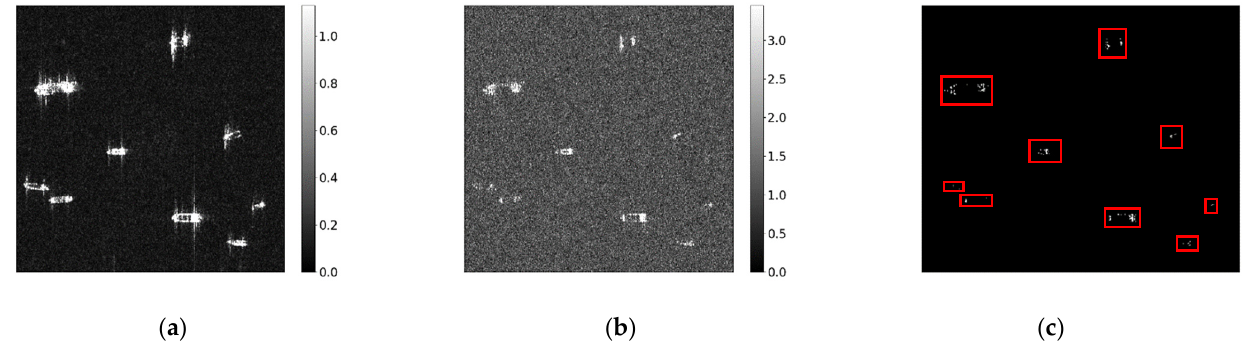
Figure 6. ( a ) Reference TerraSAR-X image in spotlight mode, ( b ) simulated image as if acquired with one of the two ambiguous modes that considers the worse NESZ and the increased sea clutter level due to the higher ambiguity level, and ( c ) the detection map with the regions of interest indi- cated by the red boxes. the red